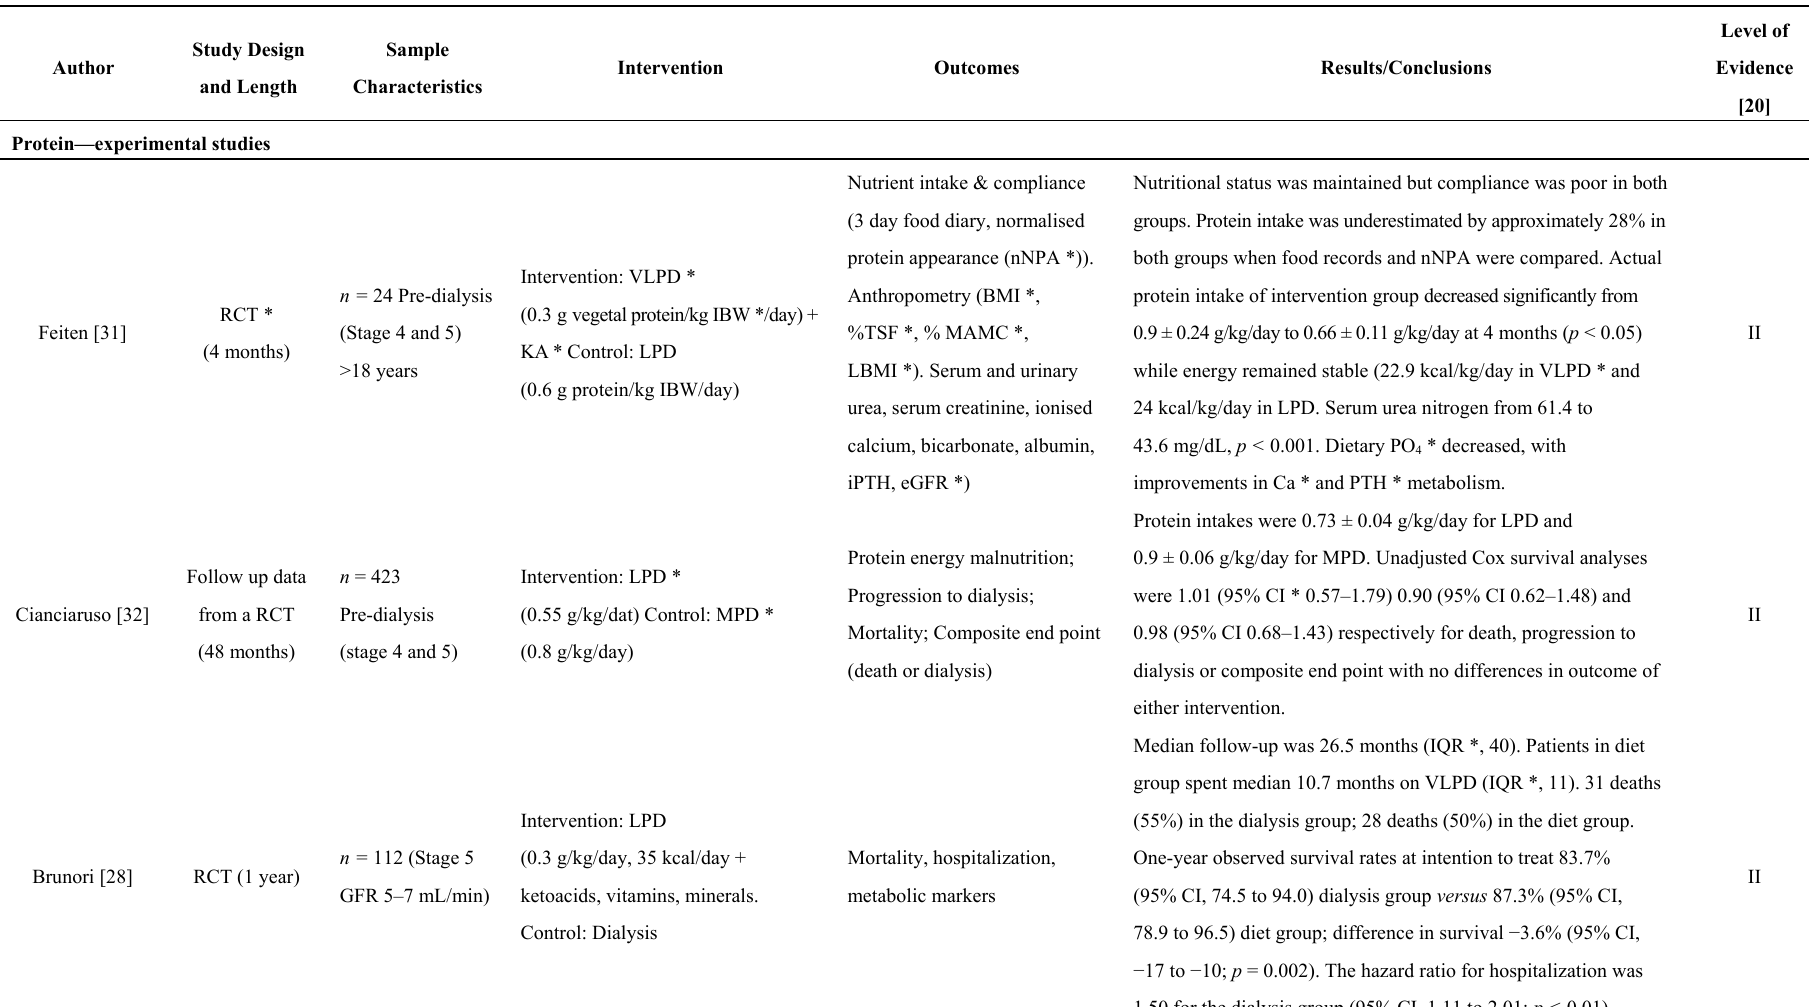
Table 2. Experimental and observational studies addressing various aspects of the nutrition prescription in